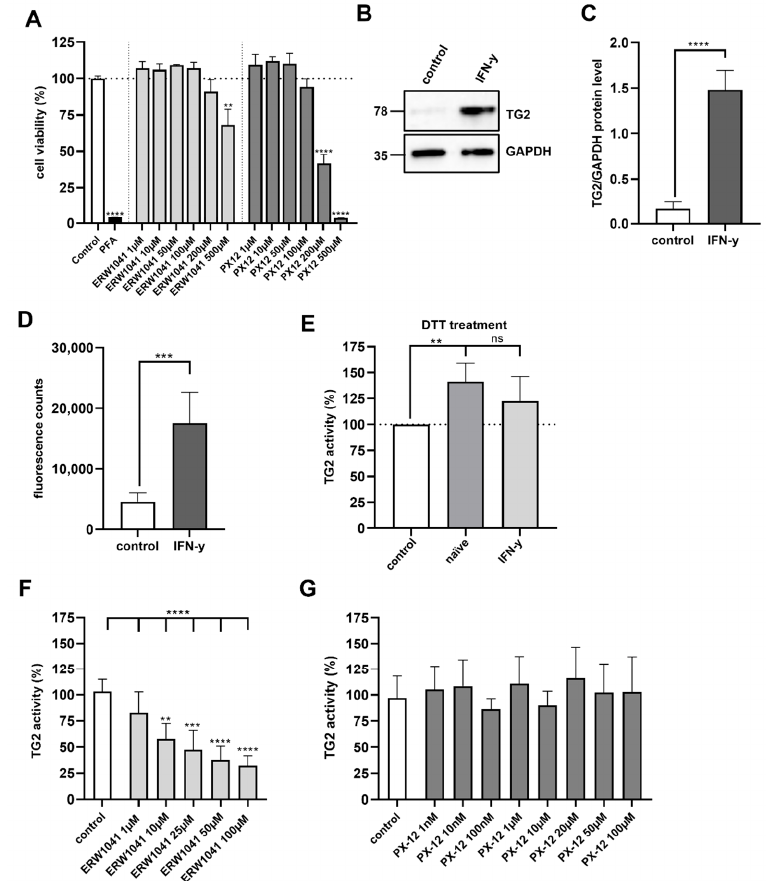
Figure 3. Evaluation of TG2 inhibition on confluent Caco-2 cell monolayers. ( A ) Cell viability of Caco-2 cells was tested after 24 h treatment with ERW1041 and PX12 at the indicated concentrations. n = 3 with three technical replicates per experiment. ( B ) Protein expression of TG2 in Caco-2 cells